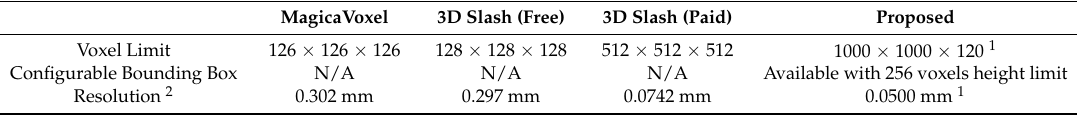
Table 2. Accuracy comparison between other voxel-based software and the proposed